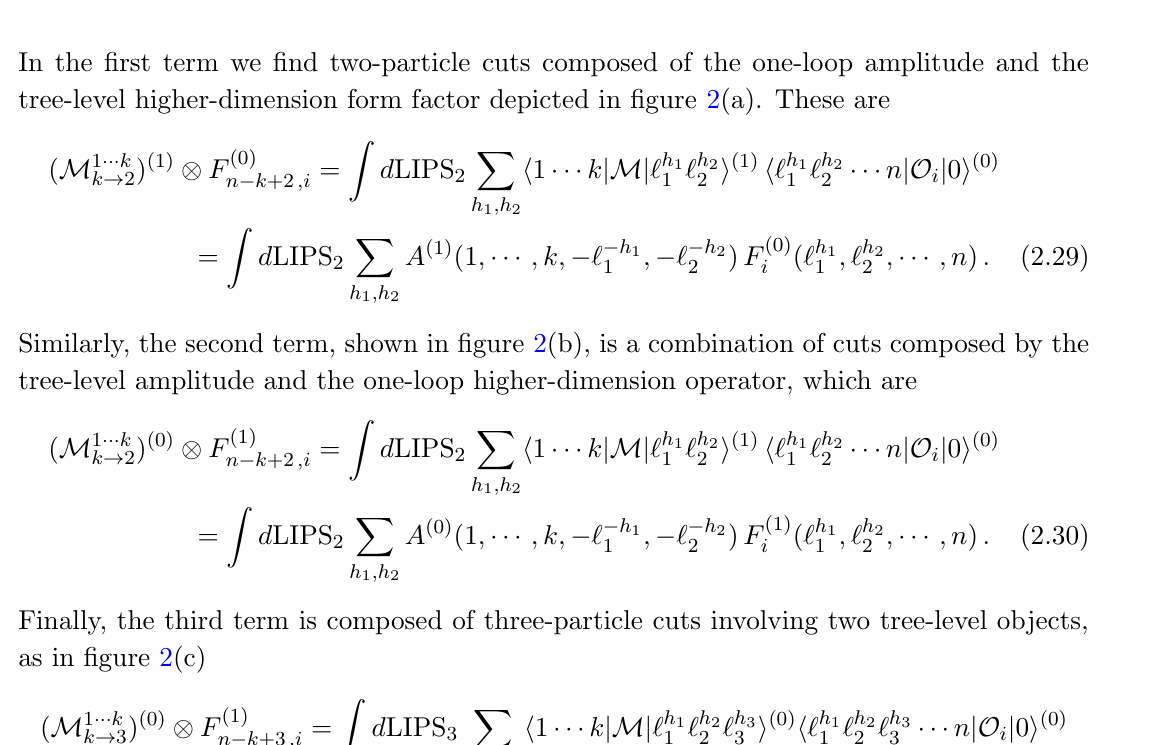
Figure 2 . Unitarity cuts relevant for the extraction of anomalous dimensions from two-loop form factors, using the same notation as in (cid:12)gure 1. The darker blobs indicate a higher-dimension operator insertion. The blobs with a hole indicate a one-loop form factor or